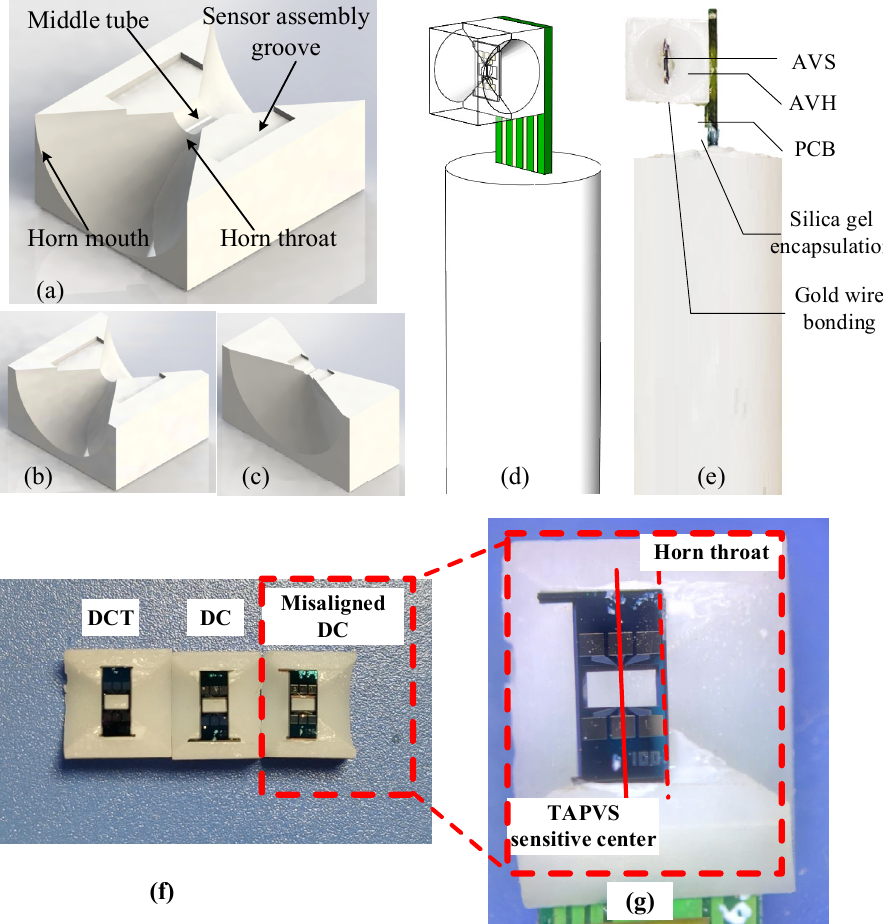
Figure 10. Schematic of: ( a ) DCT horn, ( b ) DC horn, ( c ) optimized DCT horn, ( d ) TAPVS packaged in a DC horn, and photo of ( e ) a TAPVS packaged in a DC horn; ( f ) TAPVS in different kinds of acoustics horns; ( g ) the misaligned DC sensor.